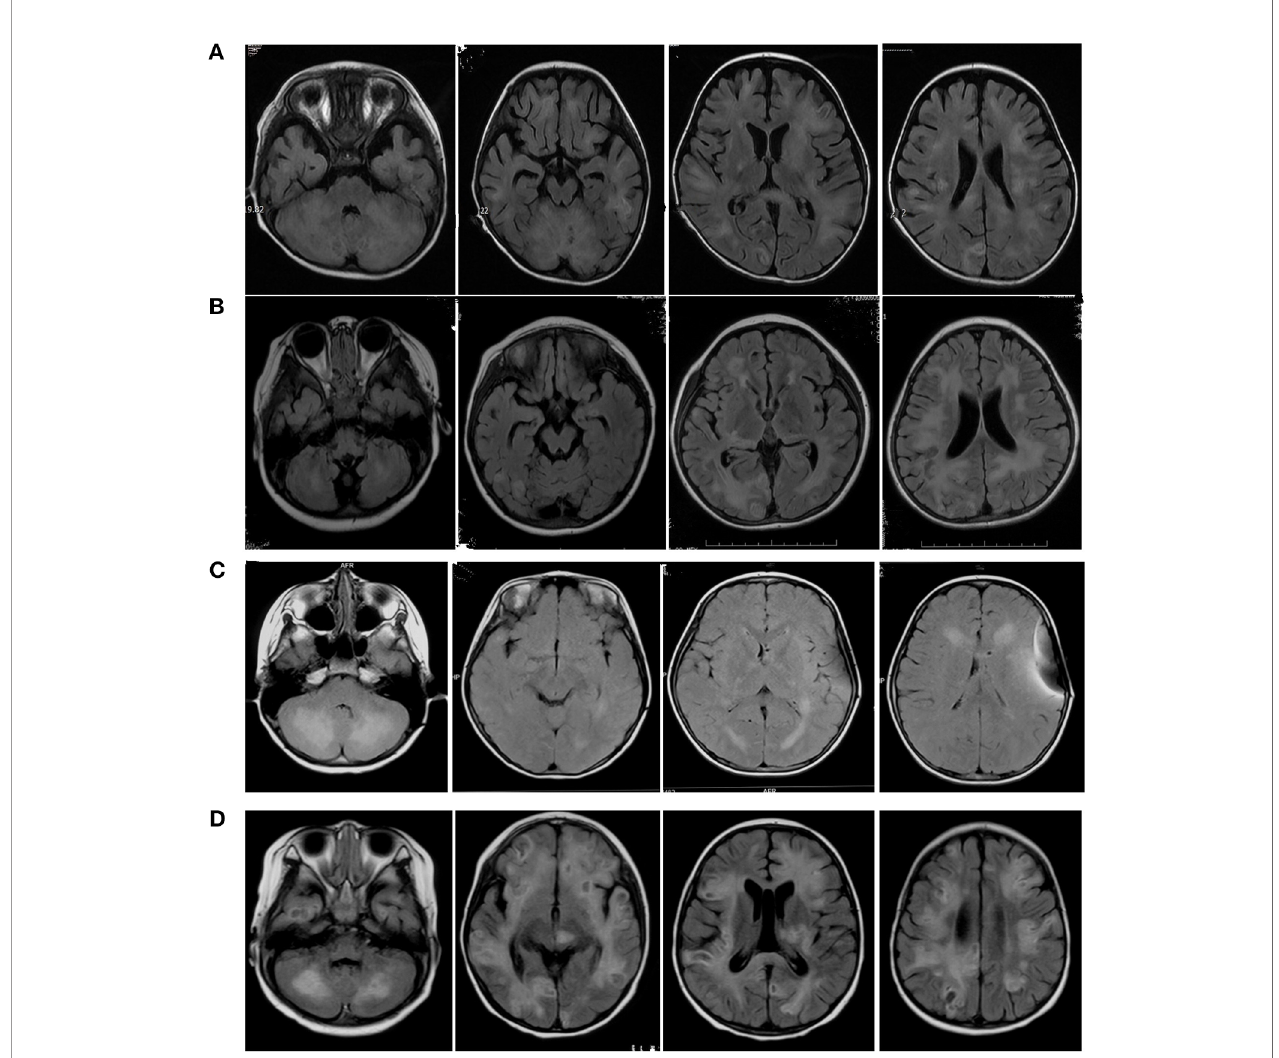
FIGURE 2 | Axial Flair sequences of brain MRIs of Case1 (A) , Case2 (B) , Case3 (C) , Case4 (D) . The FLAIR-MRI revealed numerous variable size in the cerebral hemisphere, basal ganglia, cerebellum and brain stem as well as hypersignal intensities on